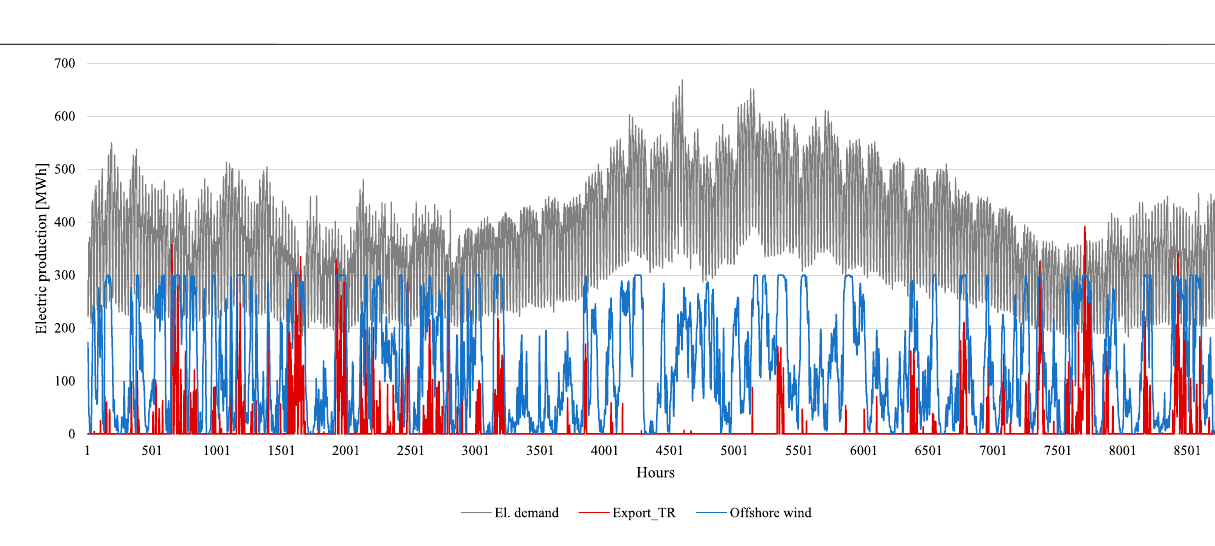
FIGURE 7 | In fl uence of the offshore wind farm on electricity